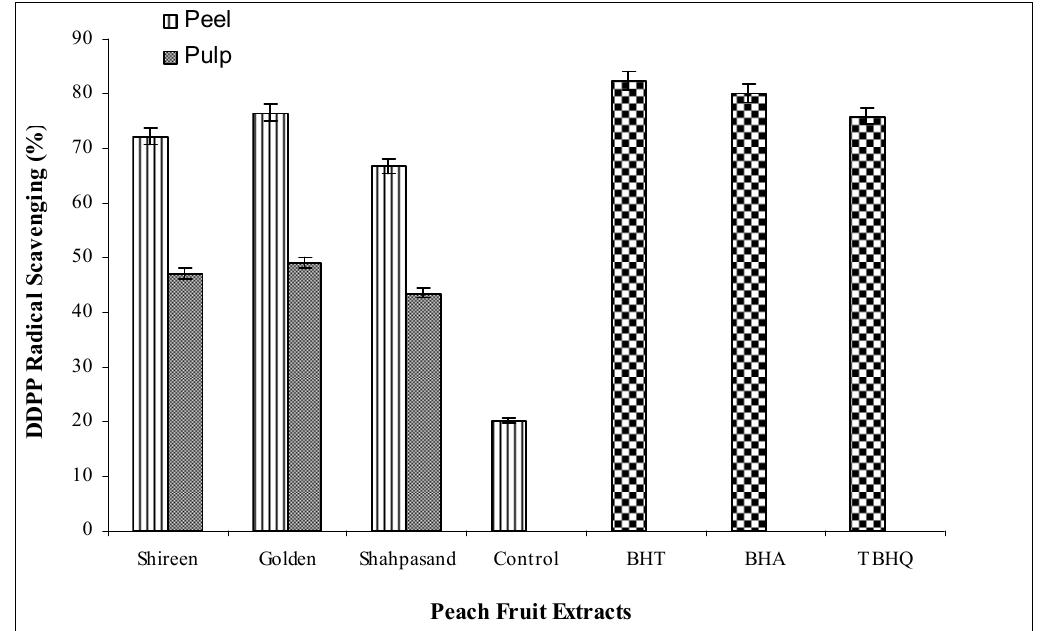
Figure 1. DPPH radical scavenging activity of 80% methanolic extracts from different varieties of peach ( Prunus persica L.)